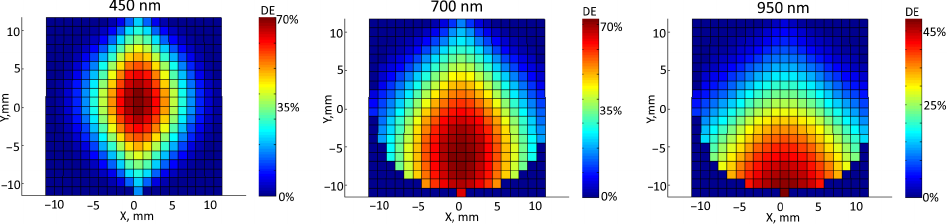
Figure 8. Spatial distribution of the DE across the beam footprint for the classical